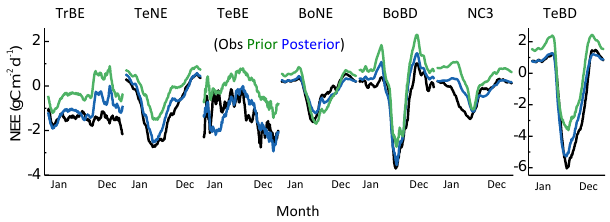
Figure 5. Mean seasonal cycle of the net ecosystem exchange (NEE) for the different plant functional type optimized in step 2 of the assimilation. The mean across all sites for a given PFT is pro- vided for the observations (black), the posterior of step 1 (green) and the posterior of step 2